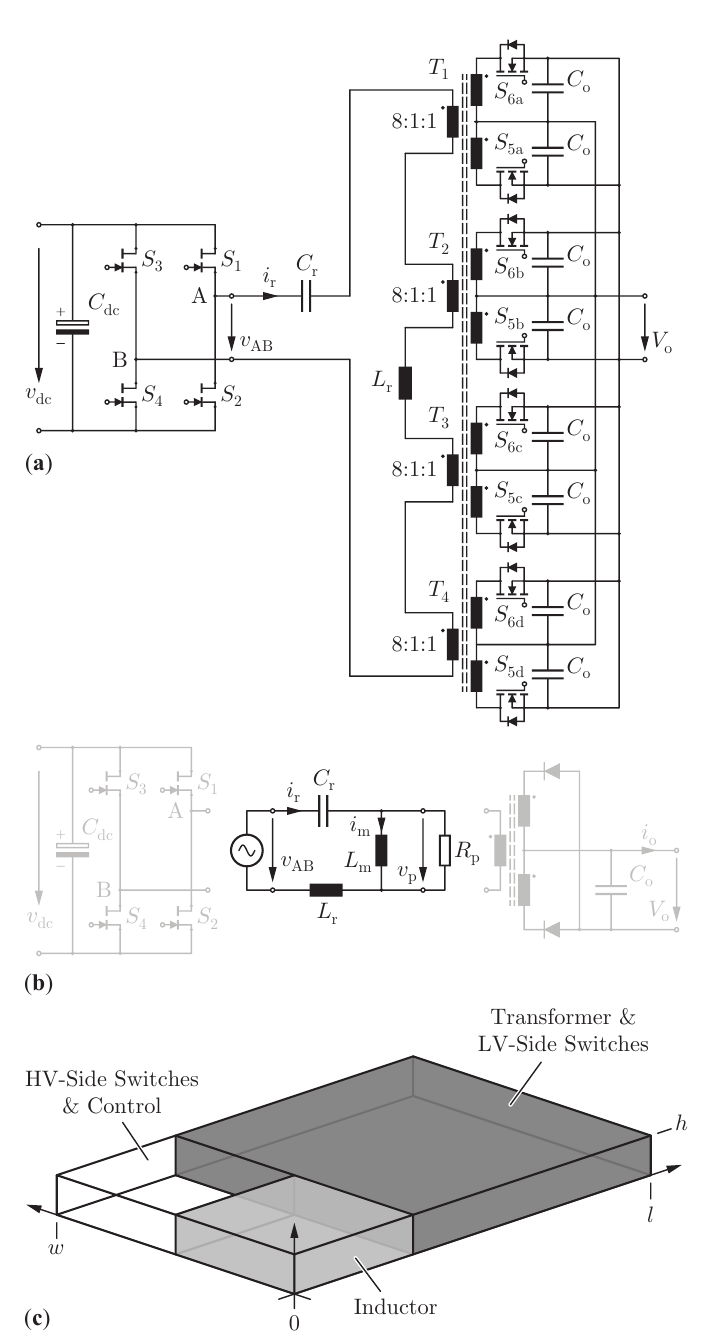
Figure 2. ( a ) Power circuit of the proposed DC/DC converter featuring GaN devices for the primary- side full-bridge, power MOSFETs operating as synchronous rectifiers on the secondary-side, and a series-input, paralleled-output, center-tapped matrix transformer. The converter operates resonantly and has the simplified circuit shown in ( b ), where the fundamental-harmonic-approximation may be used to capture the fundamental component of switched waveforms. ( c ) Proposed layout with matrix transformer, synchronous rectifiers and output capacitors as the main block defining the converter’s width ( w ) and height ( h ), and the PCB inductor and primary-side full-bridge fixing the footprint’s length ( l